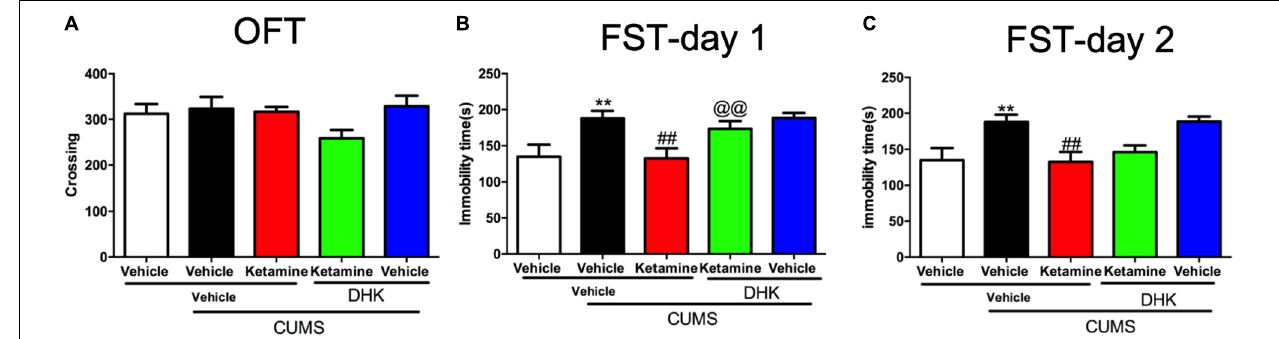
FIGURE 2 | The influence of DHK on the rapid antidepressant effect of Ketamine. The crossing of mice in OFT (A) ; the immobility time of mice in day 1 (B) ; the immobility time of mice in day 2 (C) . The data are expressed as means ± SEM, n = 10–12. ∗∗ P < 0.01 compared with vehicle + vehicle + non-stressed group;